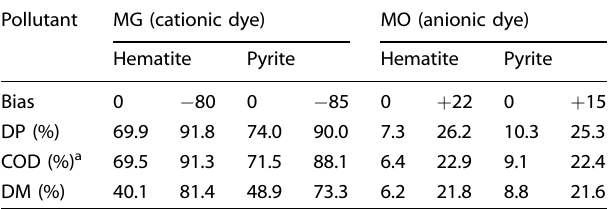
Table 2. Dye decolorization performance of the